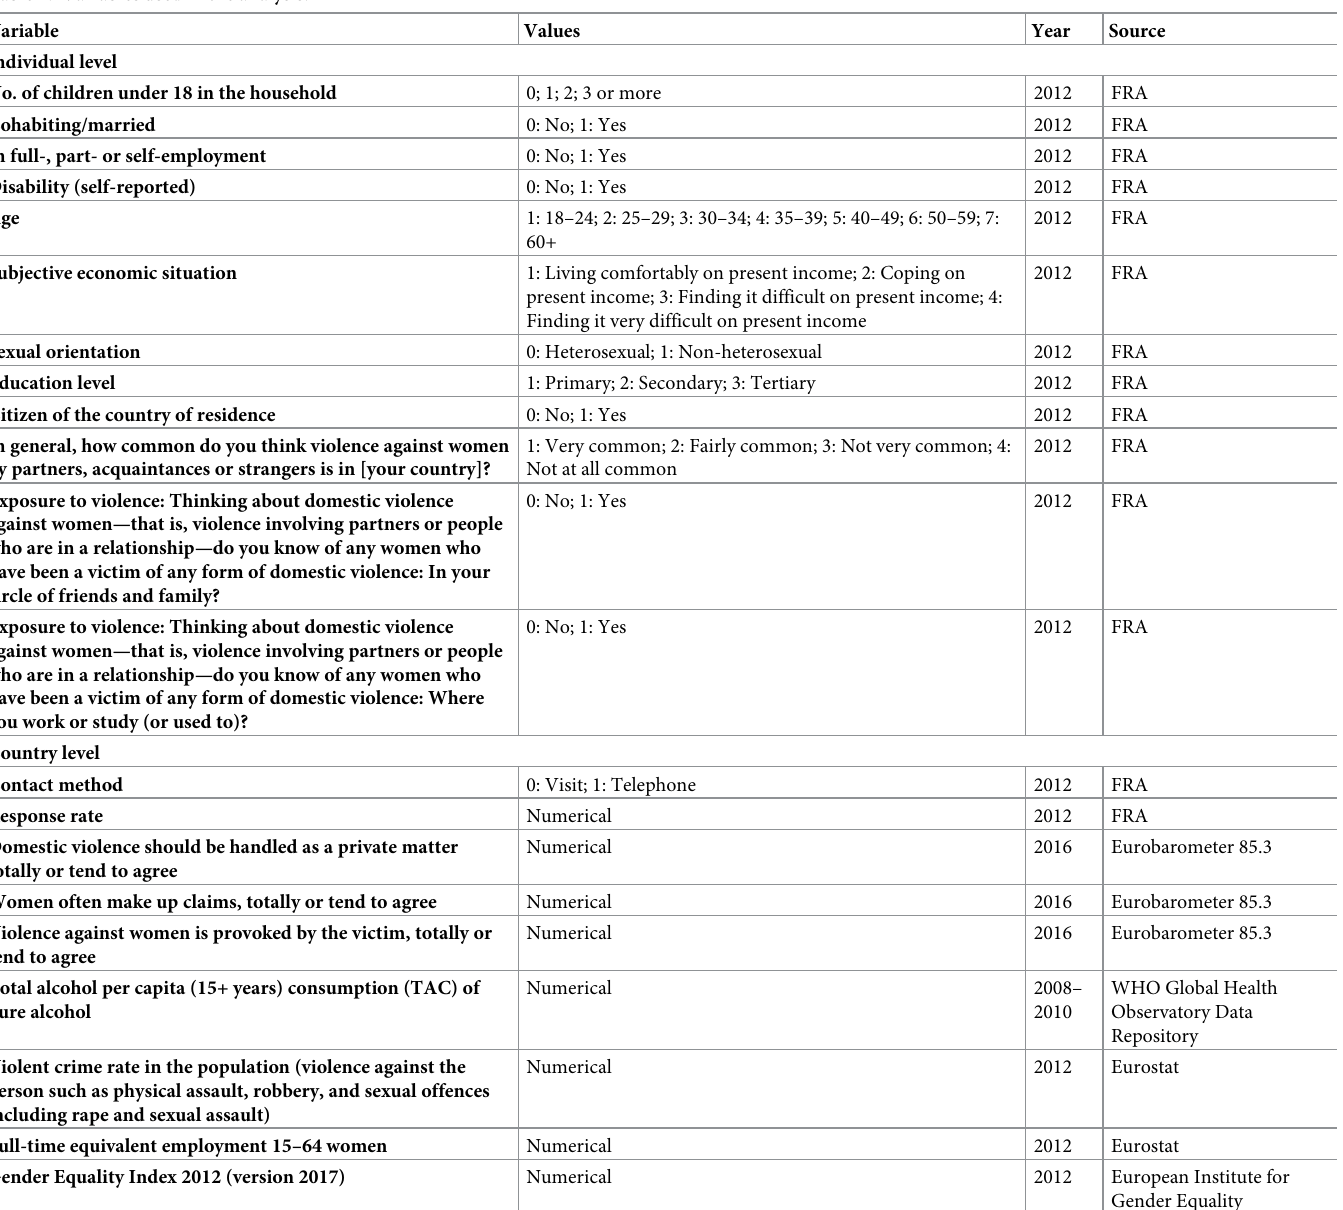
Table 2. Variables used in the